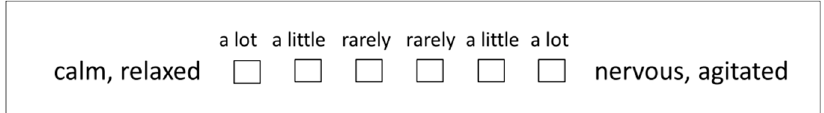
Figure 1. Example of representation of one dimension of the modified EZ-scale.